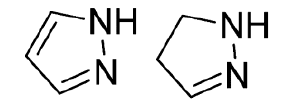
Figure 1. Structure of pyrazole and 4,5-dihydro-1 H -pyrazole.